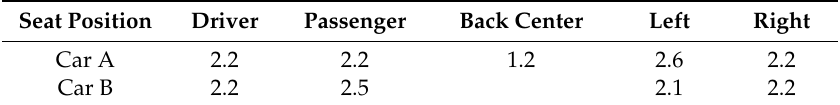
Table 4. Measured sharpness [acum] for Experiment 1.